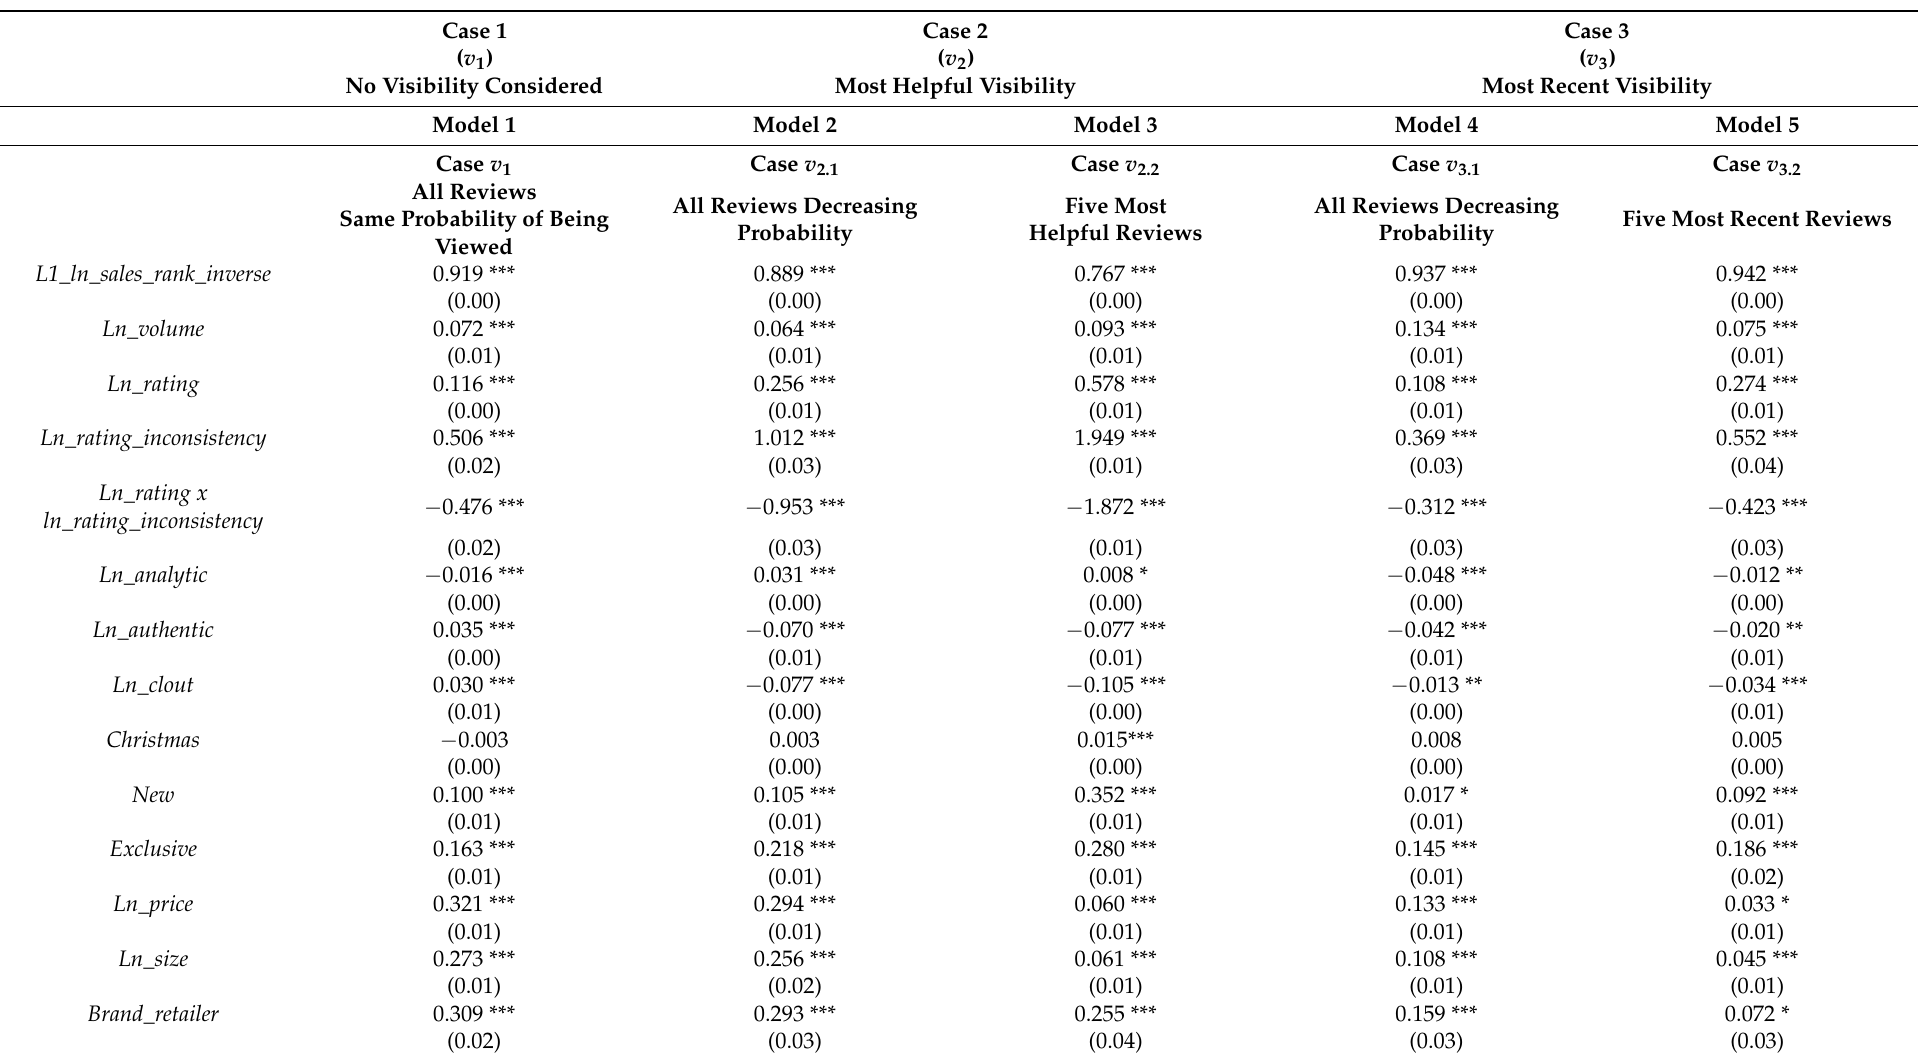
Table 4. Output of system GMM